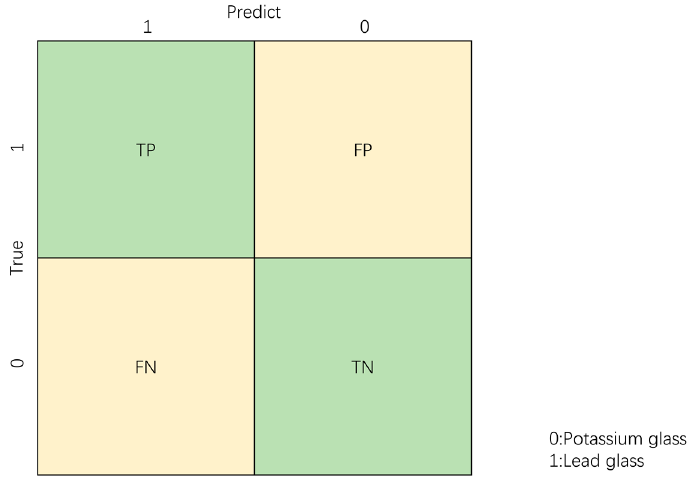
Figure 5. Confusion Matrix. TP (True Positive): correct prediction for lead glass; TN (True Negative): correct prediction for potassium glass; FP (False Positive): incorrect prediction for lead glass; and FN (False Negative): incorrect prediction for potassium glass.